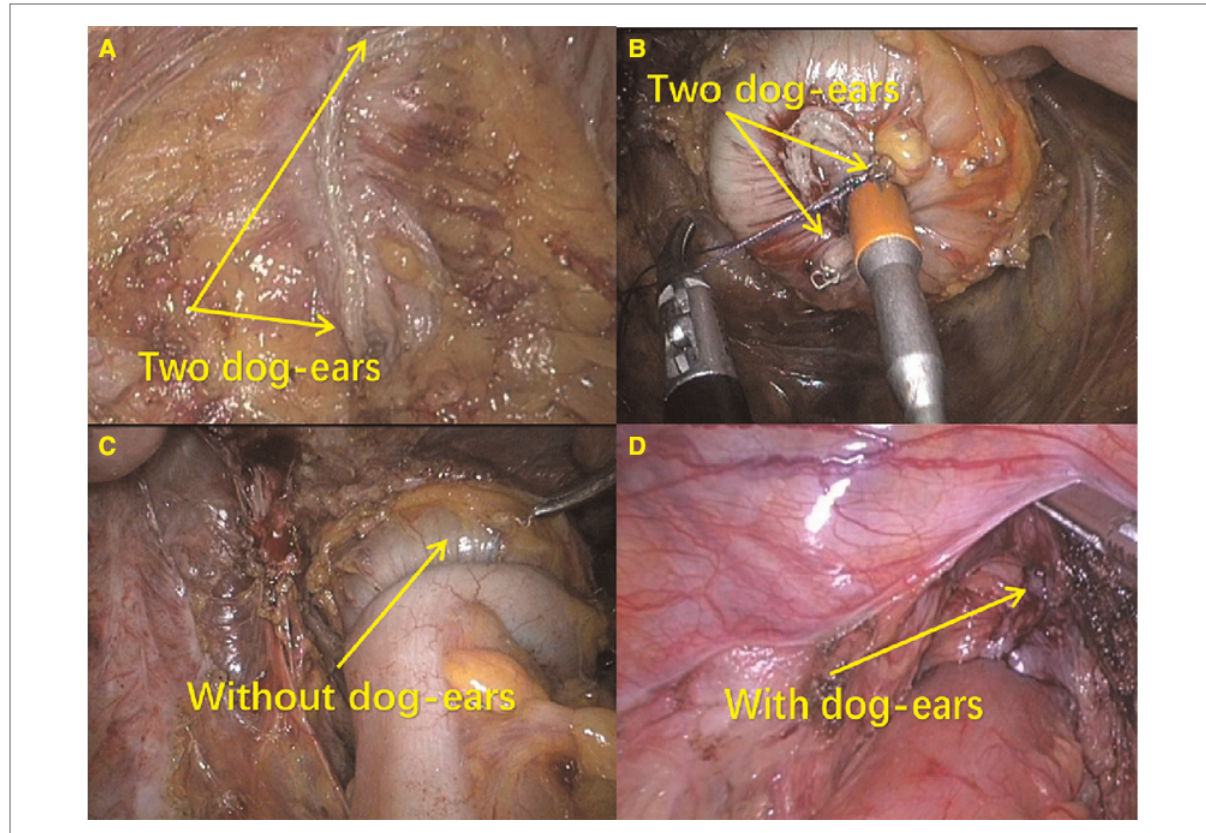
FIGURE 2 End-to-end anastomosis by DST and MDST. ( A ) Suturing two corners of the staple line around the trocar; ( B ) Without “ dog ears ” after anastomosis; ( C ) Distal rectum with “ dog ears ” ; ( D ) With “ dog ears ” after